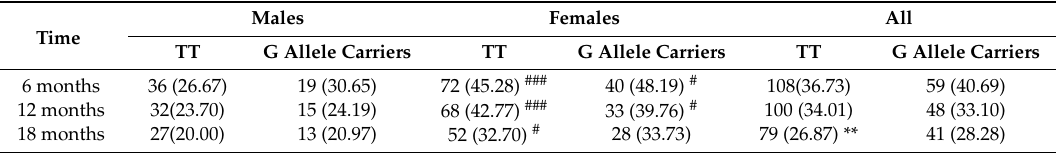
Table 2. Prevalence of depression for the subjects with different genotypes of TNFRII rs1061622 at 6, 12, and 18 months after the